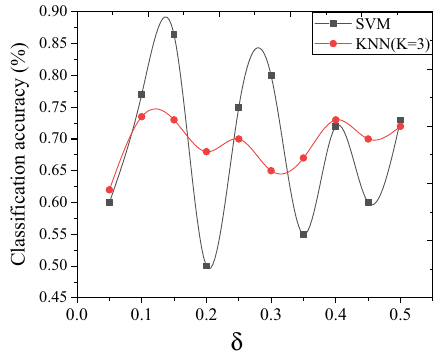
Figure 7. A-DRE attribute reduction results in the COVID-19 Dataset.